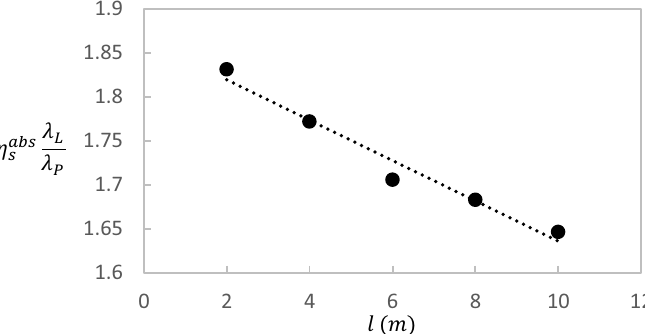
Figure 1: η sabs λ L / λ P , versus l for the Tm-doped nested-ring active fibre reported in